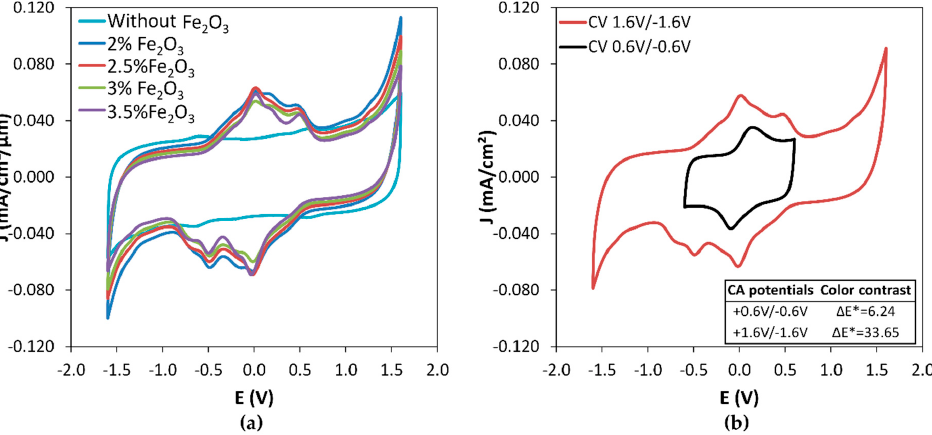
Figure 8. ( a ) Cyclic voltammograms (2 nd cycle) of the electrochromic displays obtained from PEDOT-PSS + x Fe 2 O 3 thin film with varying x from 2 wt % to 3.5 wt % compared to PEDOT:PSS without Fe 2 O 3 , ( b ) cyclic voltammograms of the electrochromic displays with PEDOT:PSS +2.5% Fe 2 O 3 at different potential ranges.